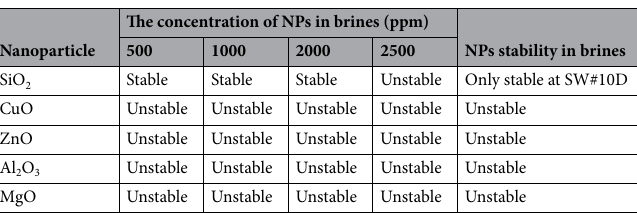
Table 7. Observation investigation of the stability of NPs at different salinities and dilution ratio of seawater as IW for 7